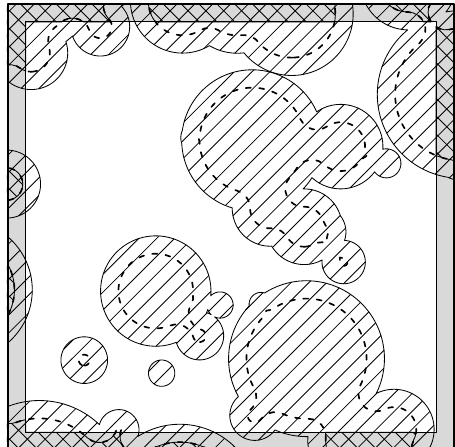
Figure 2: An example observation of a RACS, X obs (hatched regions), showing points within r distance of the window boundary (grey region) and points that are further than r distance from the outside of X obs (dashed bound- ary). The crosshatched regions are within r distance of the edge of W and further than r distance from the visible edge of X obs . Without more information it is impossible to know whether these points are in the core area of X . Reduced sample Estimator: The reduced sample estimator for the core probability is the proportion of the non-grey region that is inside the dashed boundary. Chiu-Stoyan Estimator: The Chiu-Stoyan estimator uses the length of the dashed boundary outside the grey region given by mul- tiple smaller buffer distances to estimate the core proba- bility at the desired buffer